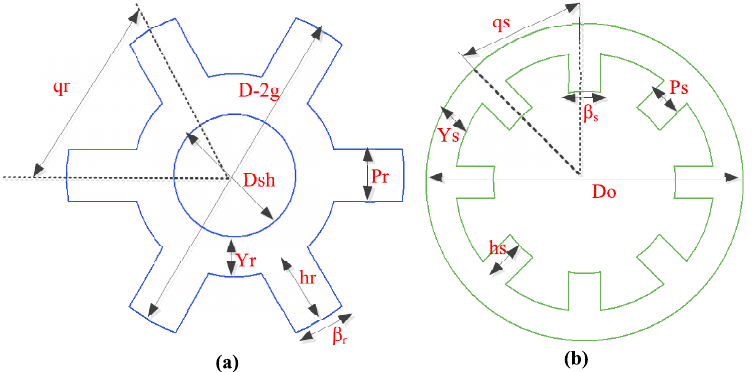
Figure 1. Geometric parameters of 8/6 SRM for ( a ) Rotor ( b )